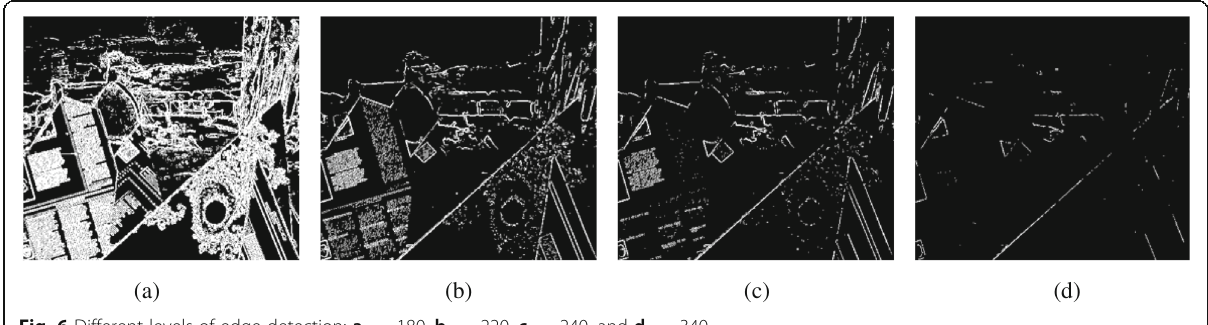
Fig. 6 Different levels of edge detection: a φ = 180, b φ = 220, c φ =240, and d φ =